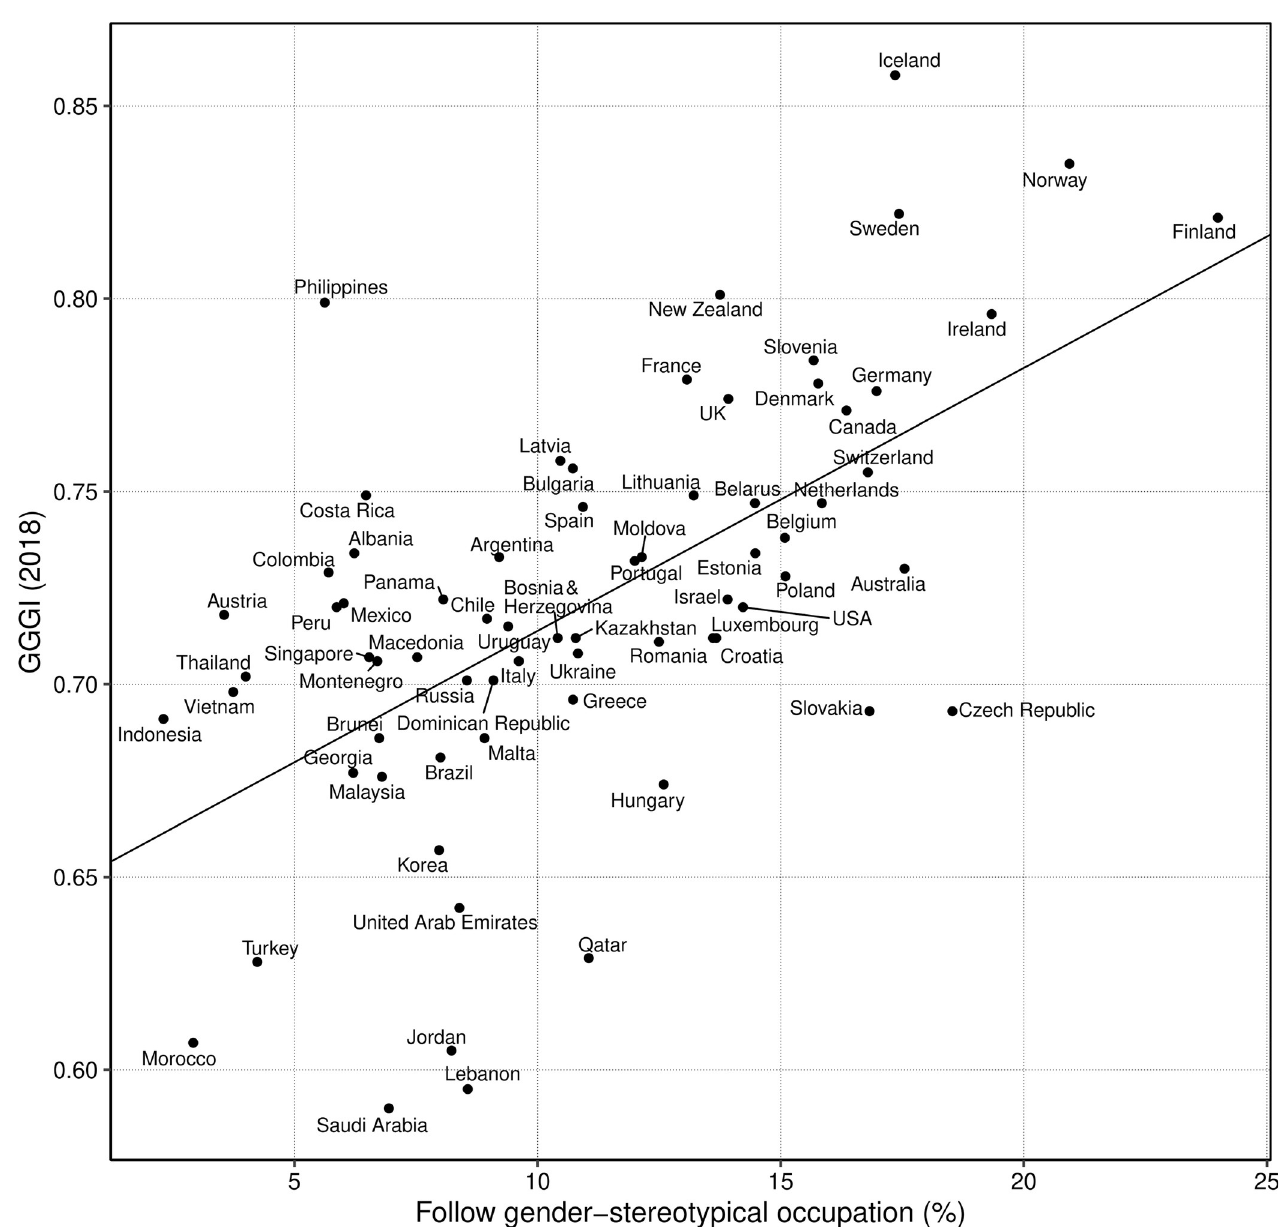
Fig 3. Percentage of students aspiring to a gender-stereotypical occupational category based on the occupation of the same-sex parent correlates with women’s empowerment (GGGI). For instance, in Finland 24% of students aspired to a gender-stereotypical occupation (boys aspiring to things-oriented or STEM occupations, and girls to people-oriented occupations) and their same-sex parent was employed in a similar occupational category. We did this by splitting the data into countries below and above the median values. The median values were 0.719 for women’s empowerment (GGGI), 472 for average PISA scores (across reading, mathematics, and achievement), and 56.4% for the percentage of students not aspiring to a sex-typical occupation. Estonia, Latvia, France, and Israel scored higher than the median on each of these three variables (Fig 4). In the Discussion, we elaborate on why these countries might have scored higher.